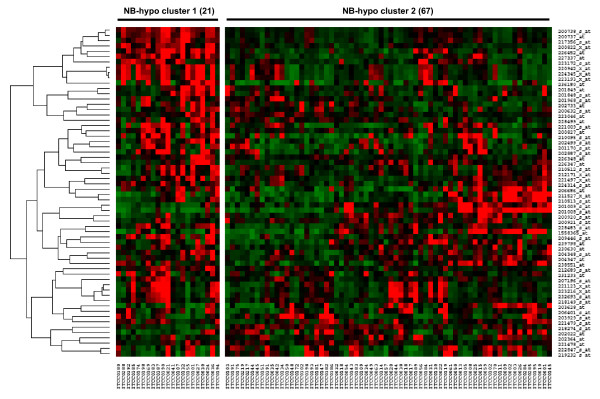
Heatmap of the 62 probesets in the 88 neuroblastoma tumors. The expression data for each individual probeset have been scaled and are represented by pseudo-colors in the heatmap. Red color corresponds to high level of expression and green color corresponds to low level of expression. The 88 patients (columns) were divided into two groups by k-means clustering. Cluster 1 consists of 21 patients and cluster 2 consists of 67 patients. The expression values of the 62 probesets were grouped by hierarchical clustering (rows). Hierarchical clustering dendrogram is on the left and the corresponding probesets on the right.